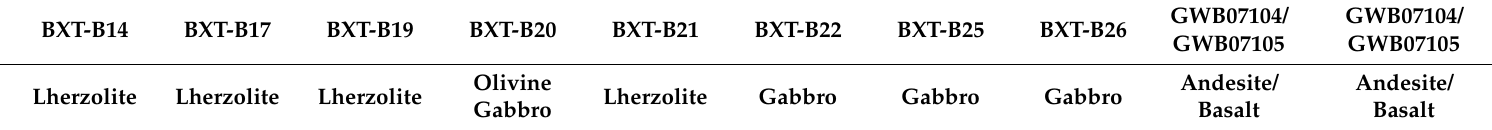
Table A3. Major (wt. %) and trace element ( × 10 − 6 ) analyses of the Baixintan